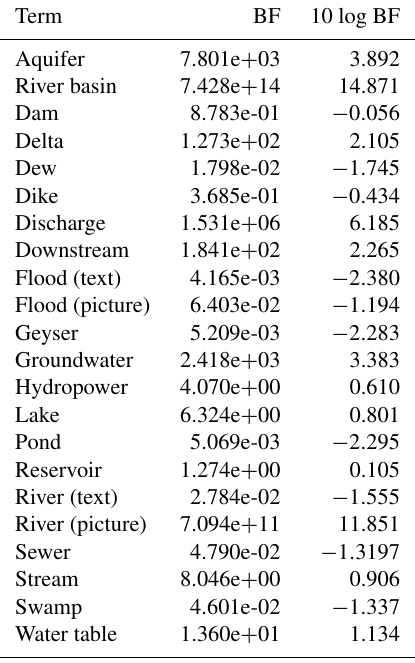
Table A1. Bayes factors (BFs) and their base-10 logarithms.